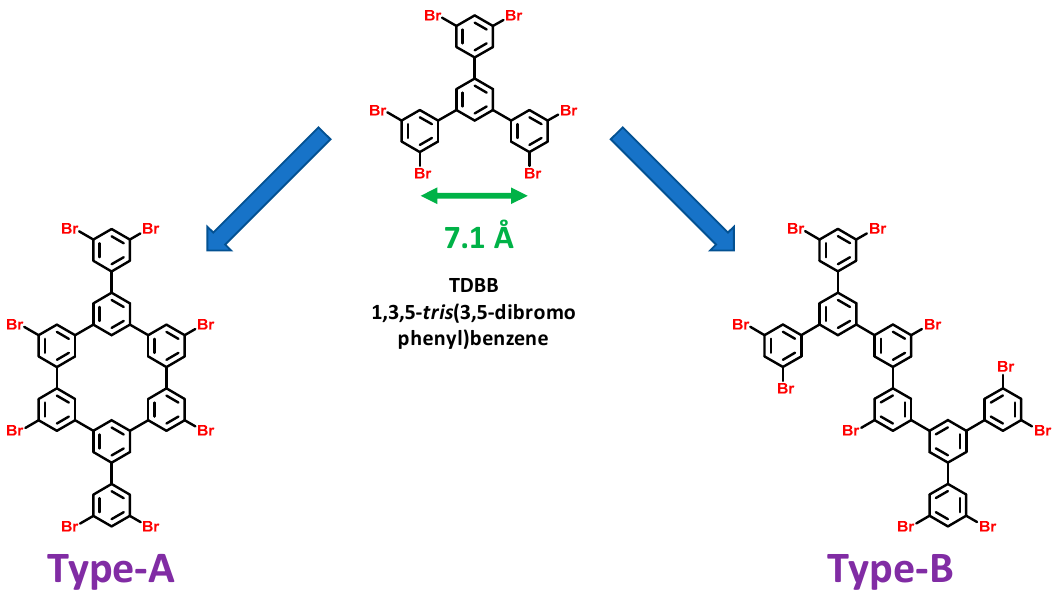
Figure 9. Scheme of the 1,3,5- tris (3,5-dibromophenyl)benzene (TDBB) dimer building block with the two-covalent-bond dimer (type-A) and the one-covalent-bond dimer (type-B).